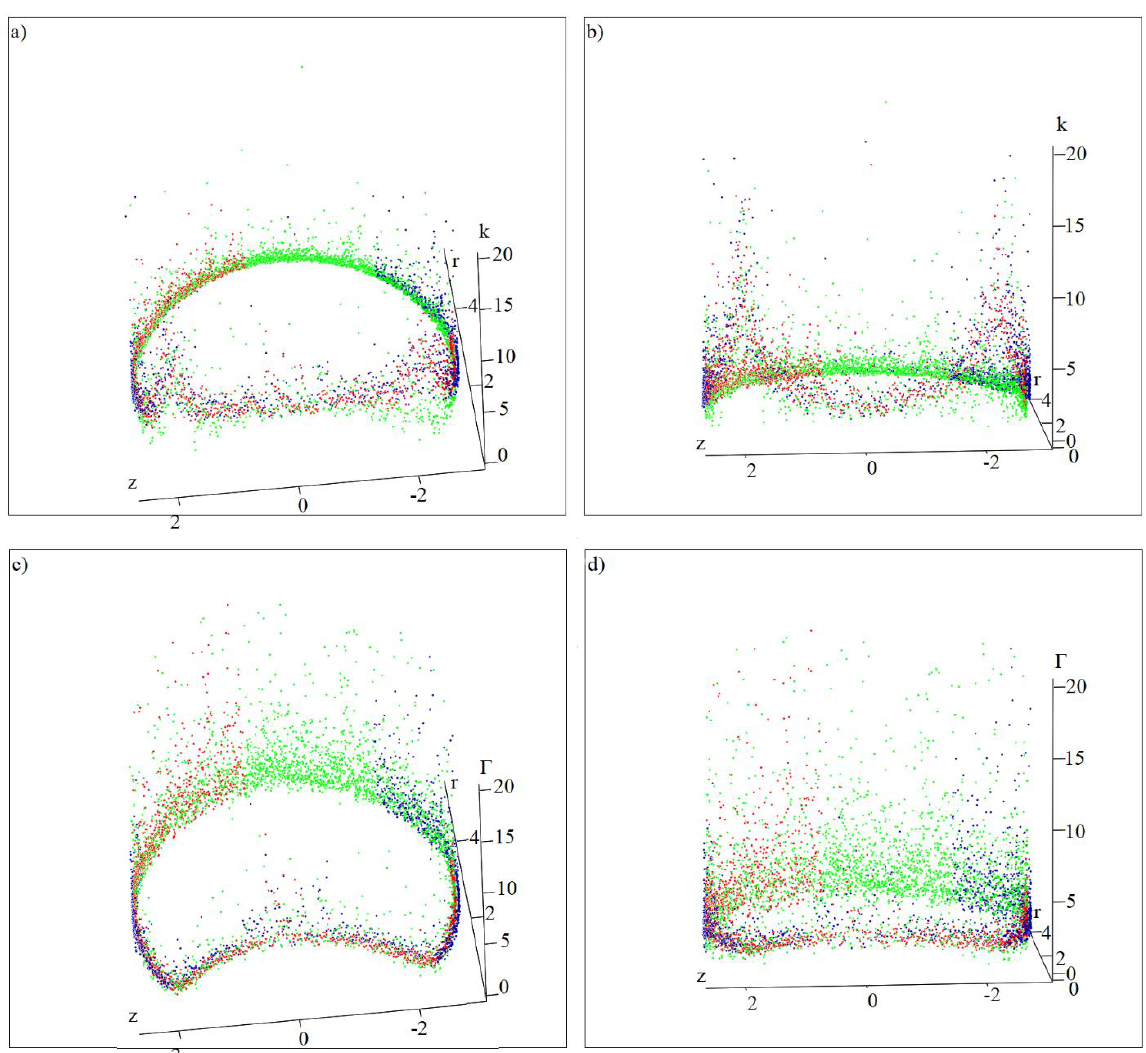
Figure 3. Verification factor according to Ulysses data in different time intervals: ( a , b ) for unipolar coefficient k and ( c , d ) for geometric factor Γ . Red—1 January 1994–26 October 1997, minimum solar activity. Blue — 21 April 2005 – 31 December 2008, minimum solar activity. Green — 27 October 1997 – 20 April 2005, maximum solar activity. Panel ( a ) differs from panel ( b ) only in the orientation of the axes relative to the reader;the difference between ( c , d ) is the same. The plane (r, z) corresponds to Figure 1. Distances along r, z are shown in AU. Dailyaveraged Ulysses data.